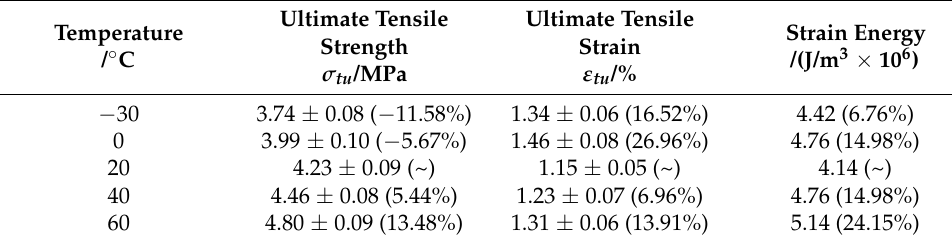
Figure 12. Tensile stress–strain relationship curve of HDC.